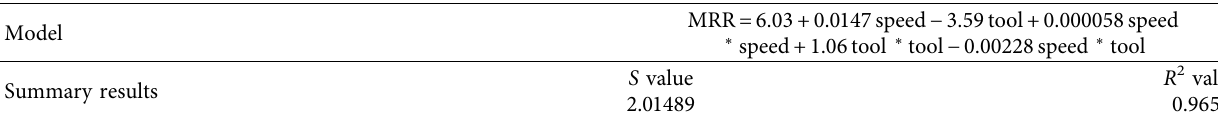
Figure 4: (a)Response surface graph for MRR (cutting speed vs. depth of cut). (b)Contour surface plot for MRR (cutting speed vs. depth of cut). Table 9: Regression model and summary results for MRR.